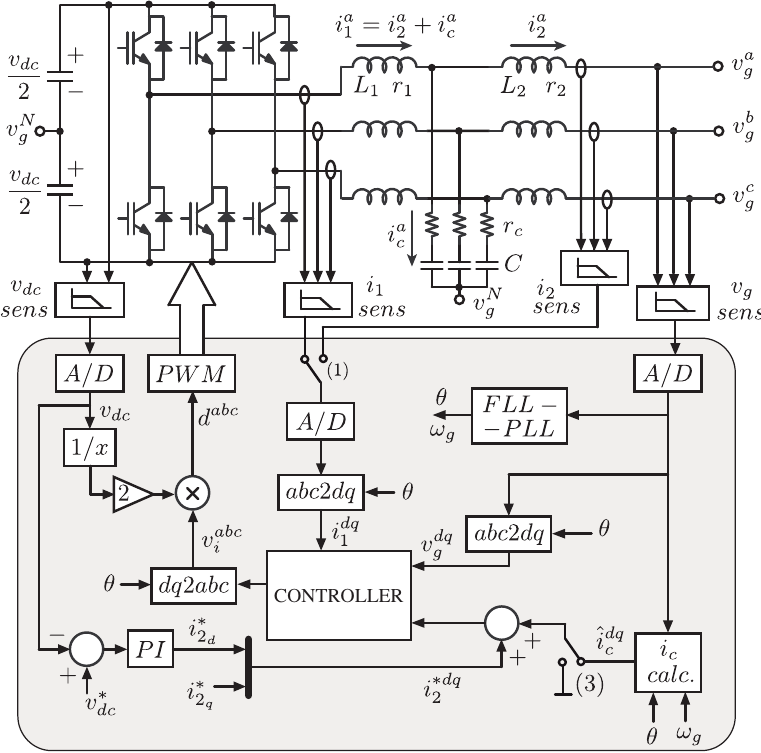
Figure 10. Transformerless three-phase grid-connected inverter with the LCL filter, current controller and CE